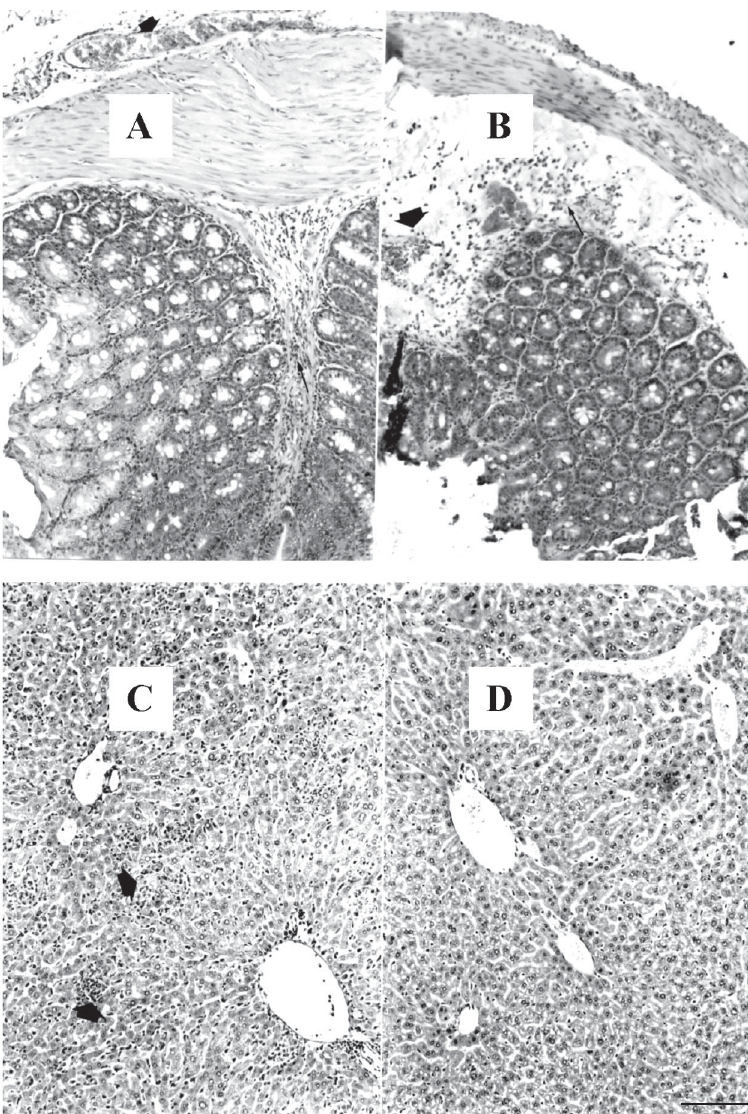
Figure 2. Histopathological aspects of the intestinal mucosa (A and B) and liver (C and D) of gnotobiotic mice challenged with Salmonella Typhimurium. Germ-free mice received PBS orally (B and D) or Escherichia coli EMO strain (A and C) 10 days before challenge. Arrows indicate inflammatory foci. Hematoxylin-eosin. Original magnification, 64X. Bar = 90.17